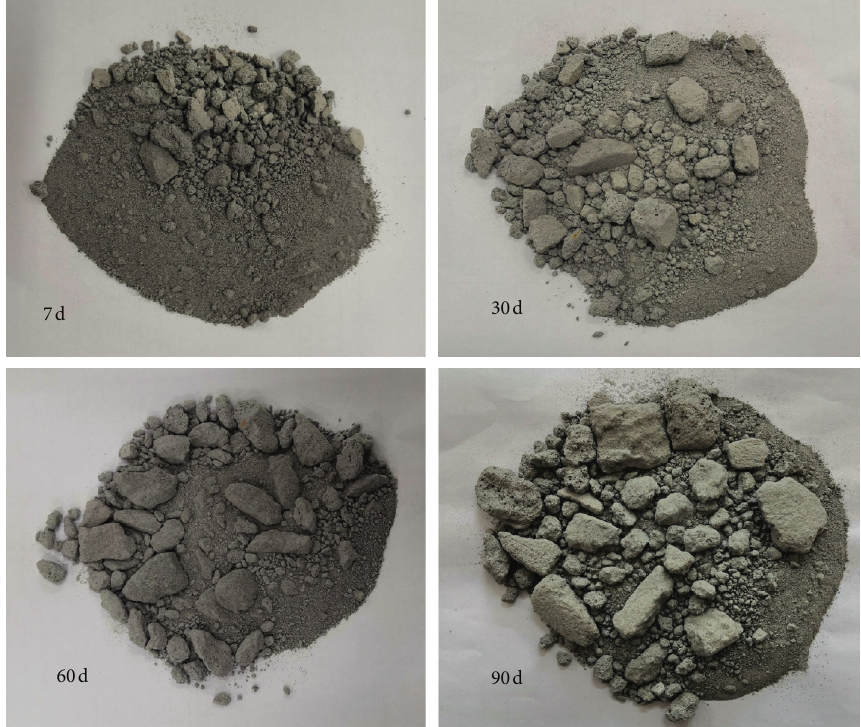
Figure 8: The failure patterns of SHPB test